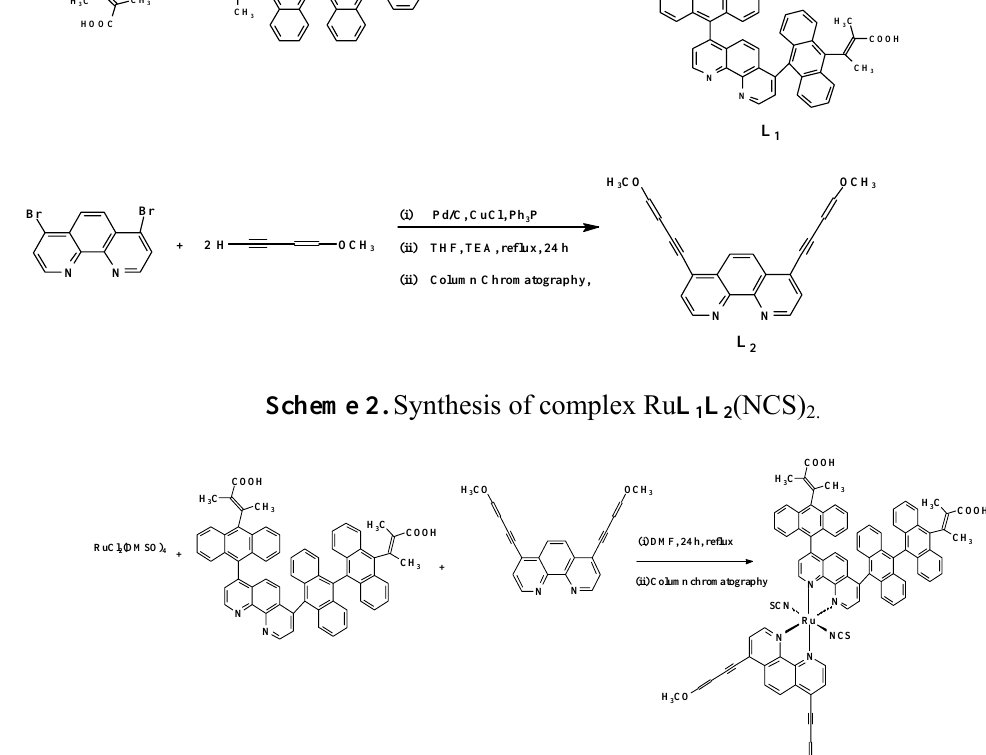
Scheme 2. Synthesis of complex Ru L